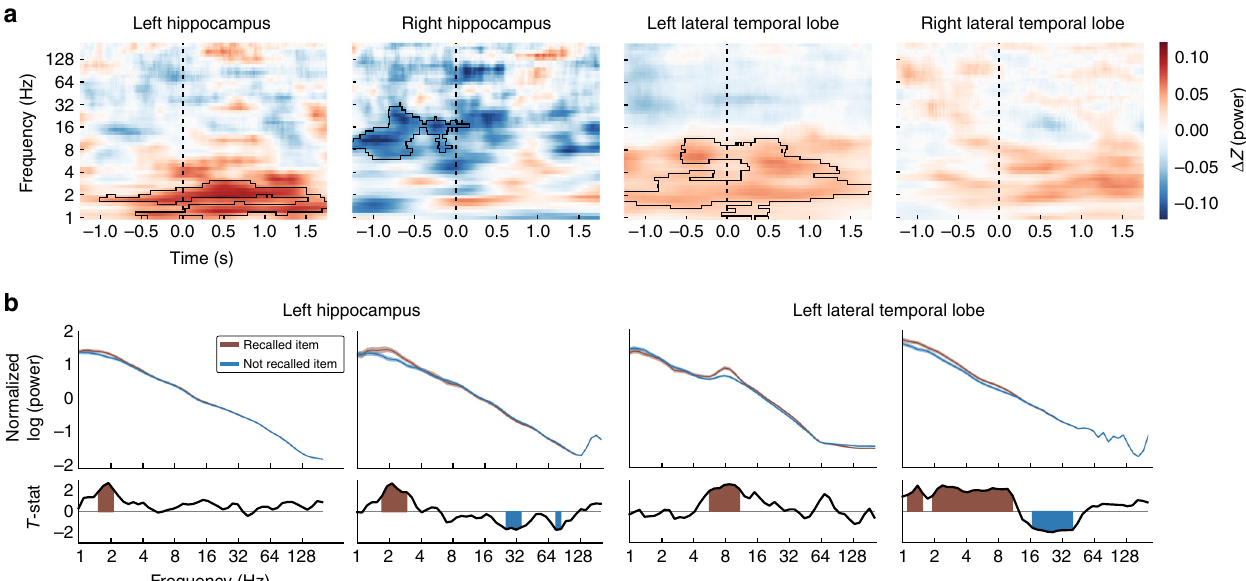
Fig. 4 Illustration of subsequent memory effects in hippocampus and temporal lobe. a Group level time – frequency spectrograms, showing mean difference in normalized power between recalled and not-recalled stimuli. Changes in power are shown at each of 50 log-spaced frequencies between 1 and 200 Hz and for 69 100-ms time bins spanning − 1.5 to 2 s relative to item onset. Black outlines indicate signi fi cant clusters of changes in power (nonparametric clustering procedure 33 p < 0.05). The dashed vertical line indicates the onset of the item. Hippocampal spectrograms include data from any electrodes in CA1, CA2, CA3, dentate gyrus or subiculum (left N = 26, right N = 21). Lateral temporal lobe electrodes include any electrodes within 2.5 cm of the coordinate of the region that showed the strongest memory-related effect in the 1 – 10 Hz band (left N = 31, right N = 30). b Top panels show example individual electrode power spectra for recalled (red) and not recalled (blue) items using average power over the 0 – 1500 ms item presentation interval. Shaded regions indicate ±1 SEM. Bottom panels show t -statistics resulting from two-sample t -tests comparing z -scored power between recalled and not- recalled items at each frequency. Colored regions indicate signi fi cance at p < 0.05. From left to right: subjects 47, 42, 29, and